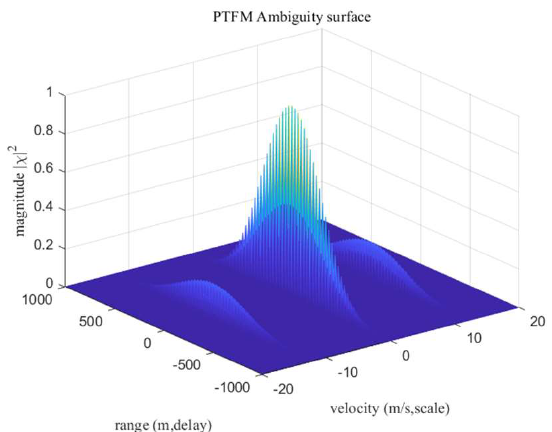
Figure 2. Ambiguity surface of a 2 s, 200 Hz PTFM waveform with 48 sub−pulses.